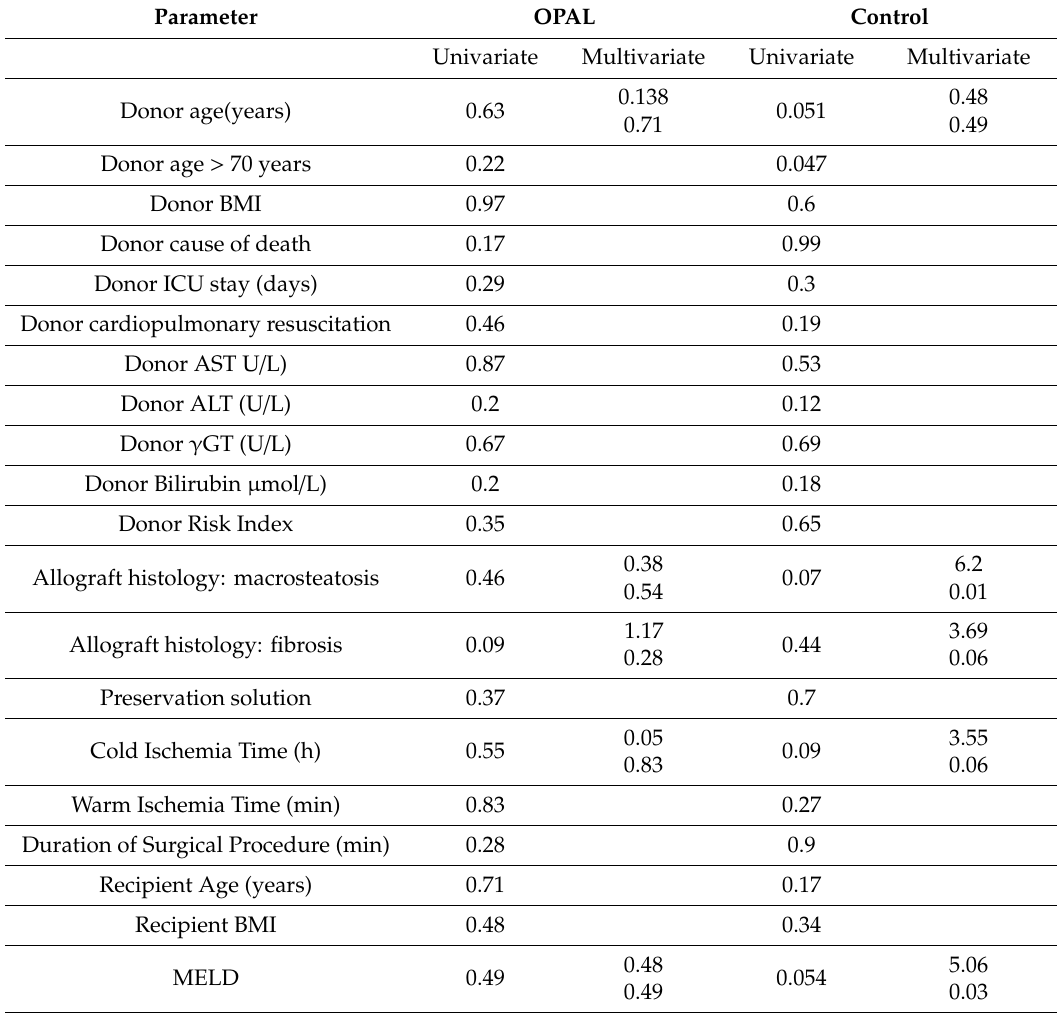
Table 4. Cox proportional hazard analysis ( p -values), censored for long term patient survival and treatment